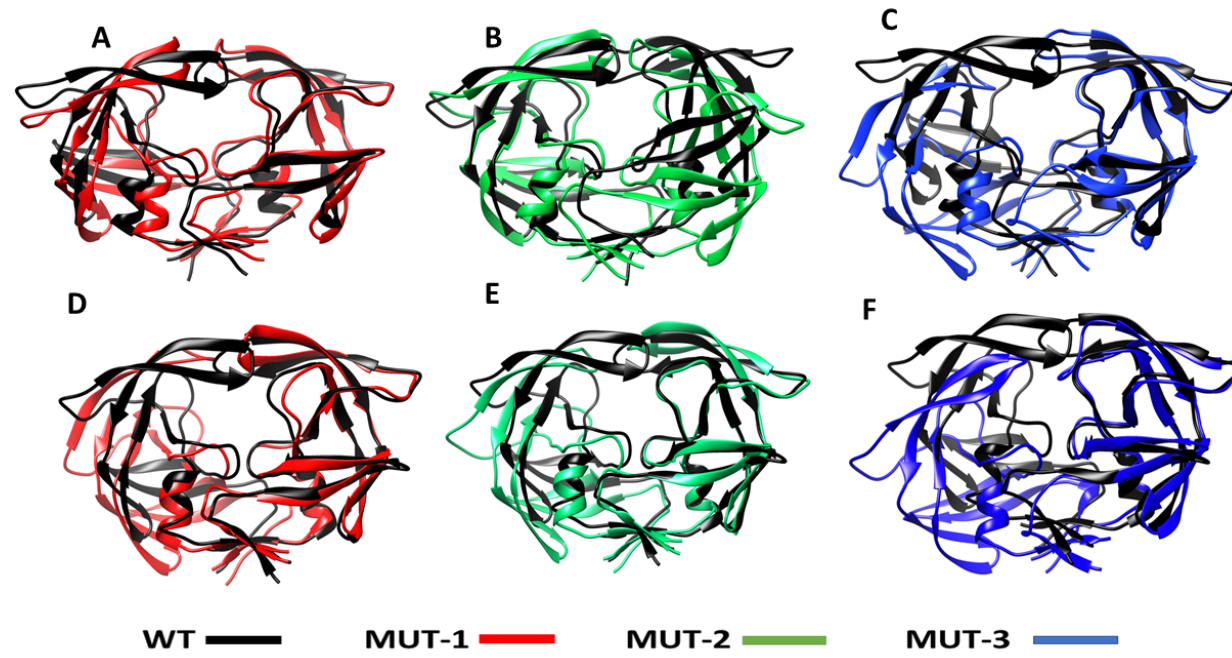
Figure 9. Superimposed structure of WT and the different mutants LPV and DRV complexes. ( A ) Superimposed structure of the WT-LPV and MUT-1-LPV complex. ( B ) Superimposed structure of the WT-LPV and MUT-2-LPV complex. ( C ) Super- imposed structure of the WT-LPV and MUT-3-LPV complex. ( D ) Superimposed structure of the WT-DRV and MUT-1-DRV complex. ( E ) Superimposed structure of the WT-DRV and MUT-2-DRV complex. ( F ) Superimposed structure of the WT-DRV and MUT-3-DRV